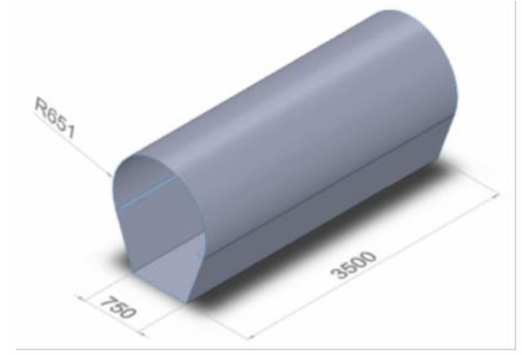
Figure 5. Isometric view of the shell (dimensions in